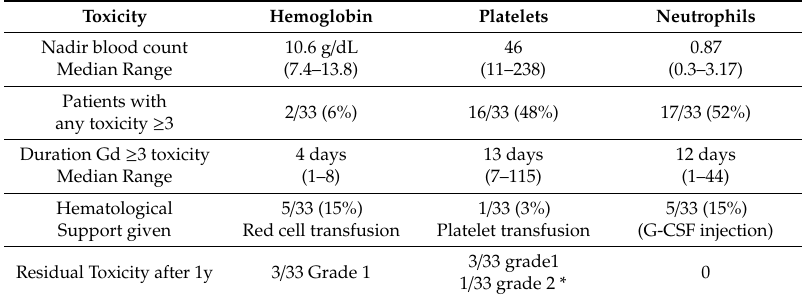
Table 3. Hematologic toxicity of radiation therapy. G-CSF = granulocyte colony-stimulating factor. Toxicity Hemoglobin Platelets Neutrophils Nadir blood count 10.6 g / dL Median Range